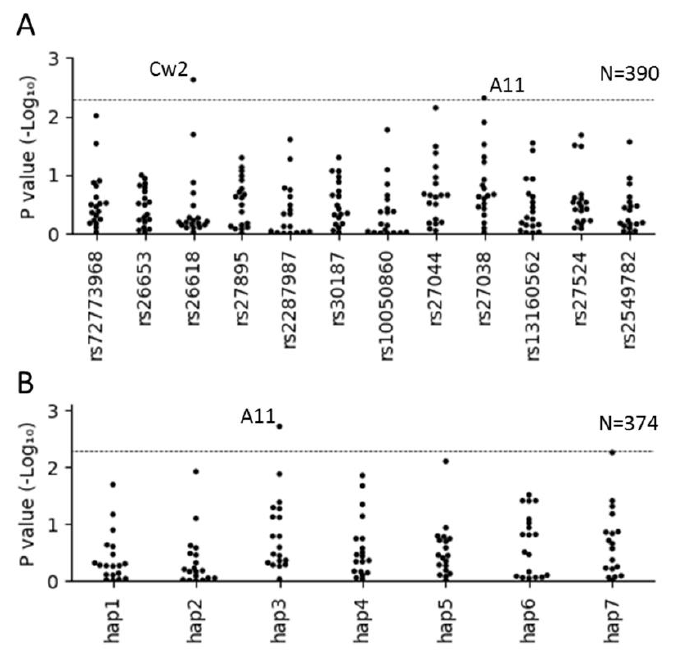
Figure 2. Association analysis of ERAP1 and ERAP2 SNPs and haplotypes with HLA phenotype in HL patients. ( A ) SNPs are ordered by chromosomal position. Genotyped or best guess ERAP genotypes and typed or best guess HLA phenotypes were used. ( B ) ERAP1 haplotypes are ordered from high to low frequency in the CEU population. The best guess ERAP1 haplotypes and typed or best guess HLA phenotypes were used. Samples were excluded if the maximum probability of a haplotype combination was <0.9. Logistic regression analysis was used to determine significance of associations. A p -value of <0.005 (dashed line) was considered significant.